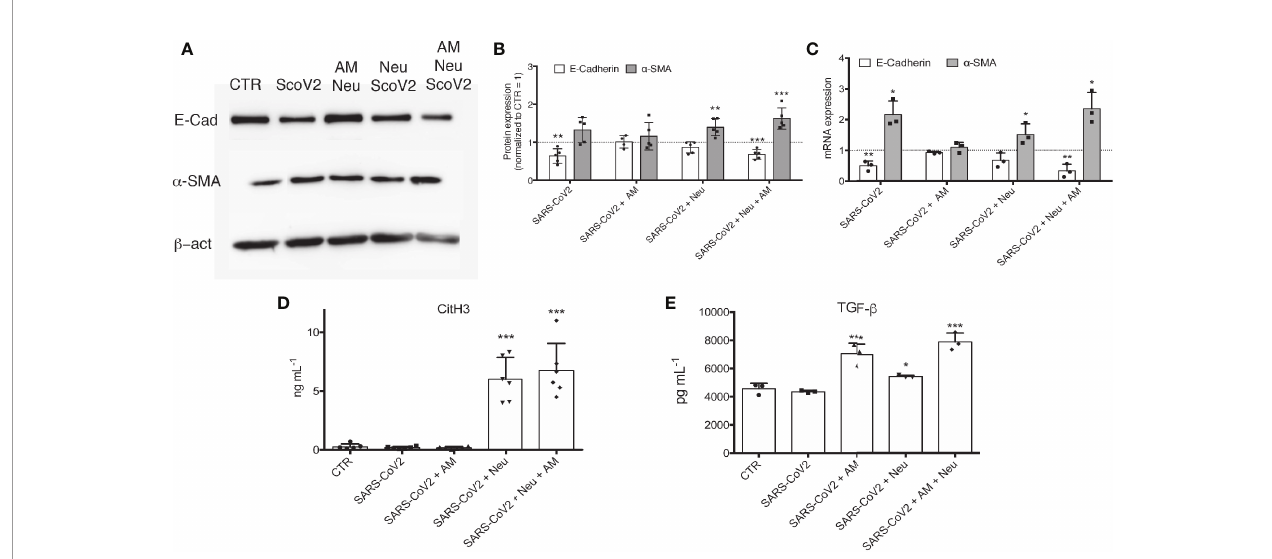
FIGURE 4 | (A) Representative immunoblots of A549 treated with different conditions for 48 h. Membrane was immunodecorated with antibodies speci fi c for E-Cadherin, a -SMA and b -actin. (B) Semiquantitative analysis of immunoblots and (C) RT-PCR analysis of airway in vitro model cultured with SARS-CoV2, AM+SARS-CoV2, Neu+SARS-CoV2 or Neu+AM+SARS-CoV2 after 48 h of treatment. (D) NETs quanti fi cation by CitH3 ELISA. (E) TGF- b quanti fi cation by ELISA assay. Data are represented as mean ± SD. ***p < 0.001 vs . CTR; *p < 0.05 vs . CTR; **p < 0.01 vs .